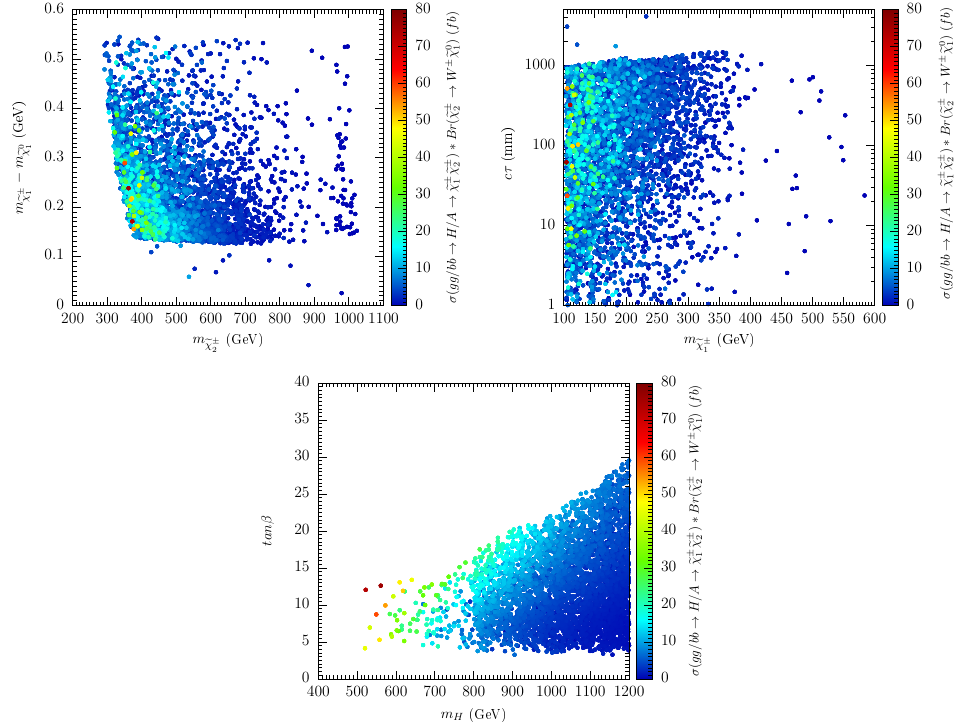
Figure 8. The event yield for χ ± production from heavy Higgs in m e 1 cay length- m and m H – tan β plane for all points passing phenomenological constraints. The e χ ± 1 chargino-neutralino mass difference does not include loop corrections discussed in the text. Event yields as a function of heavier chargino and chargino-neutralino mass difference (top left), as a function of lightest chargino mass and lifetime (top right) and as a function of heavy Higgs mass and tan β are